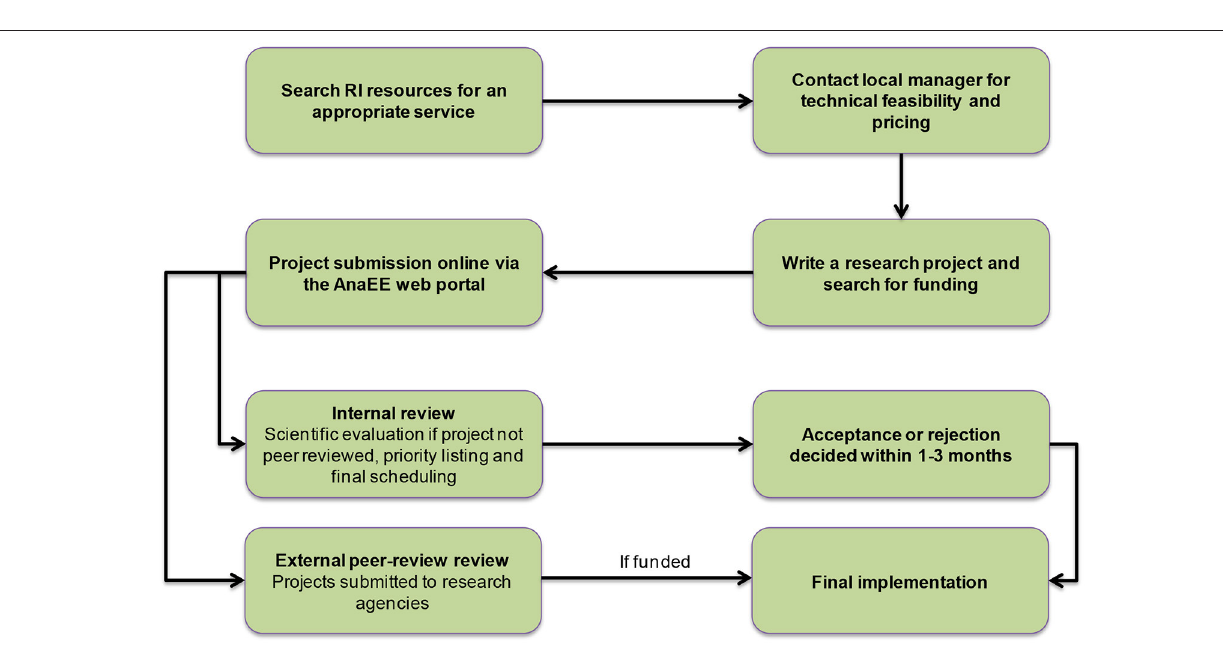
of variables and metadata across platforms, data querying and the management of rights. For short-term experiments, a dedicated web application, called ISIA (Information System for